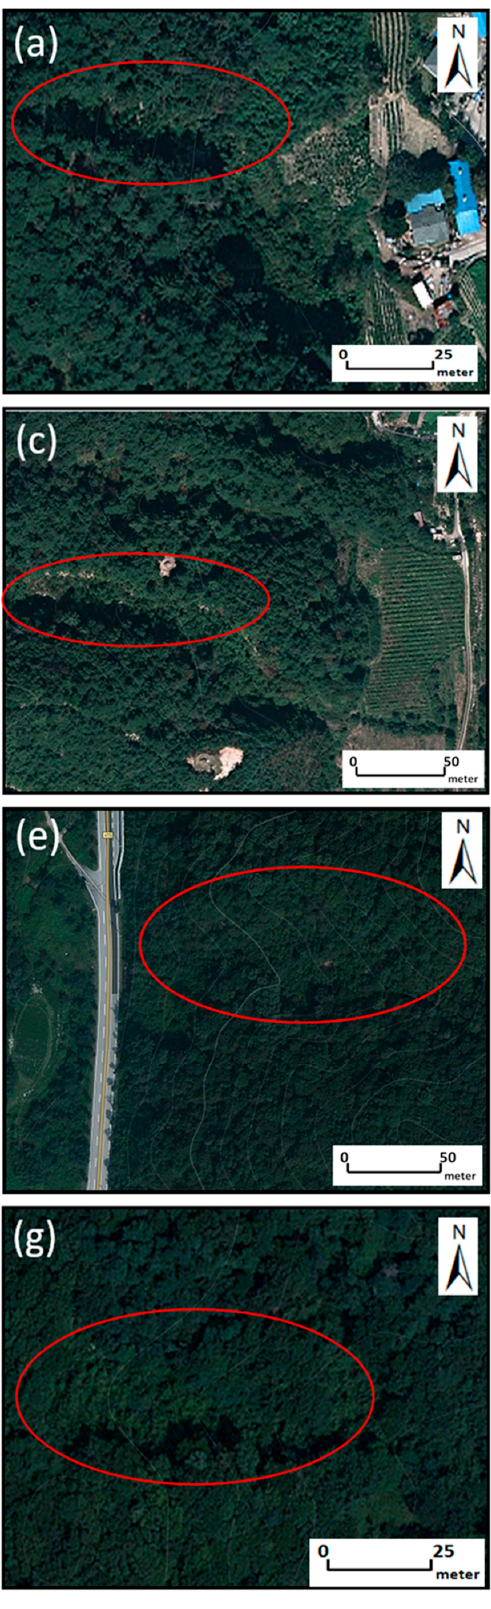
Figure 2. Satellite image of respective areas ( a , c , e , g ) before landslide occurrences from Daummap 2011 and ( b , d , f , h ) after landslide occurrences from Daummap 2008 [43].